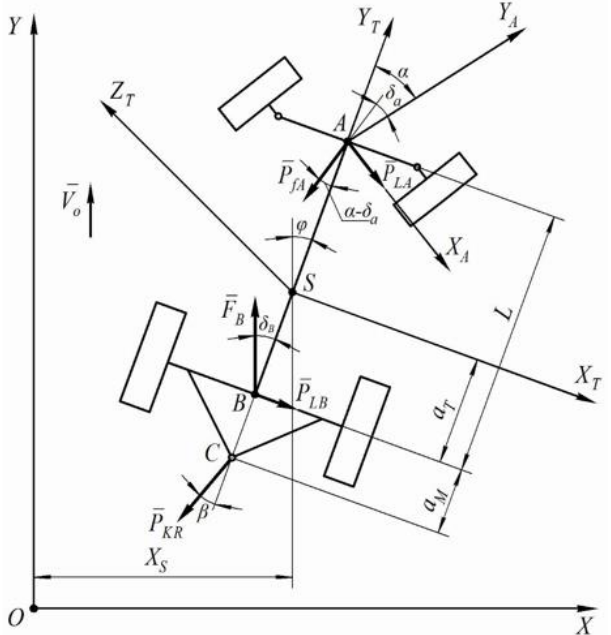
Figure 3. An equivalent scheme of the aggregating tractor in its plane-parallel movement.